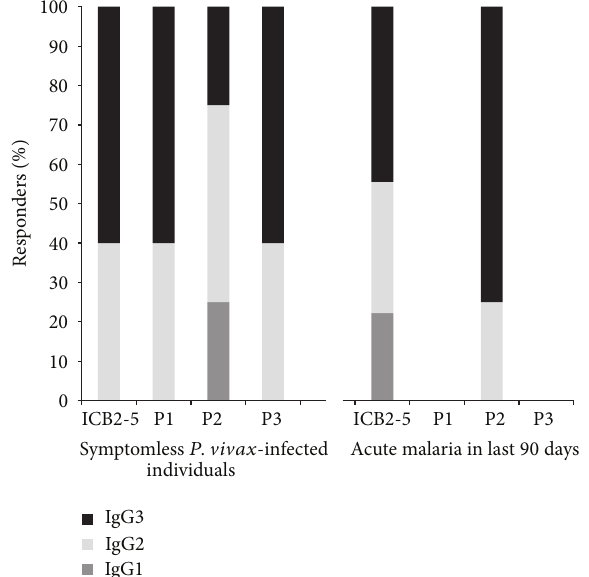
Figure 3: Frequencies of subclasses IgG responders agains a panel of variants of PvMSP1 Block 2. Percentages of subclasses responders agains ICB2-5 and a panel of major allelic variants of Block 2 expressed as recombinant proteins are shown between subjects who have had malaria in last 90 days and symptomless P. vivax -infected individuals from Rio Pardo, an agricultural settlement of Rio Pardo, Presidente Figueiredo municipality, northeast region of Amazonas State, Brazil